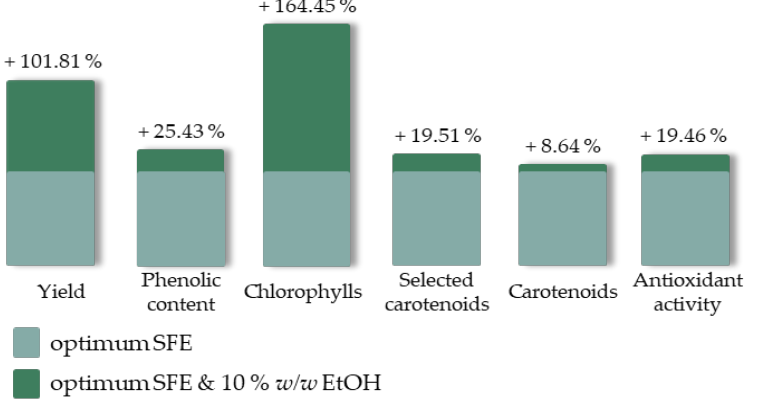
Figure 9. The effect of cosolvent addition during SFE on the examined responses expressed as a percentage alteration. percentage